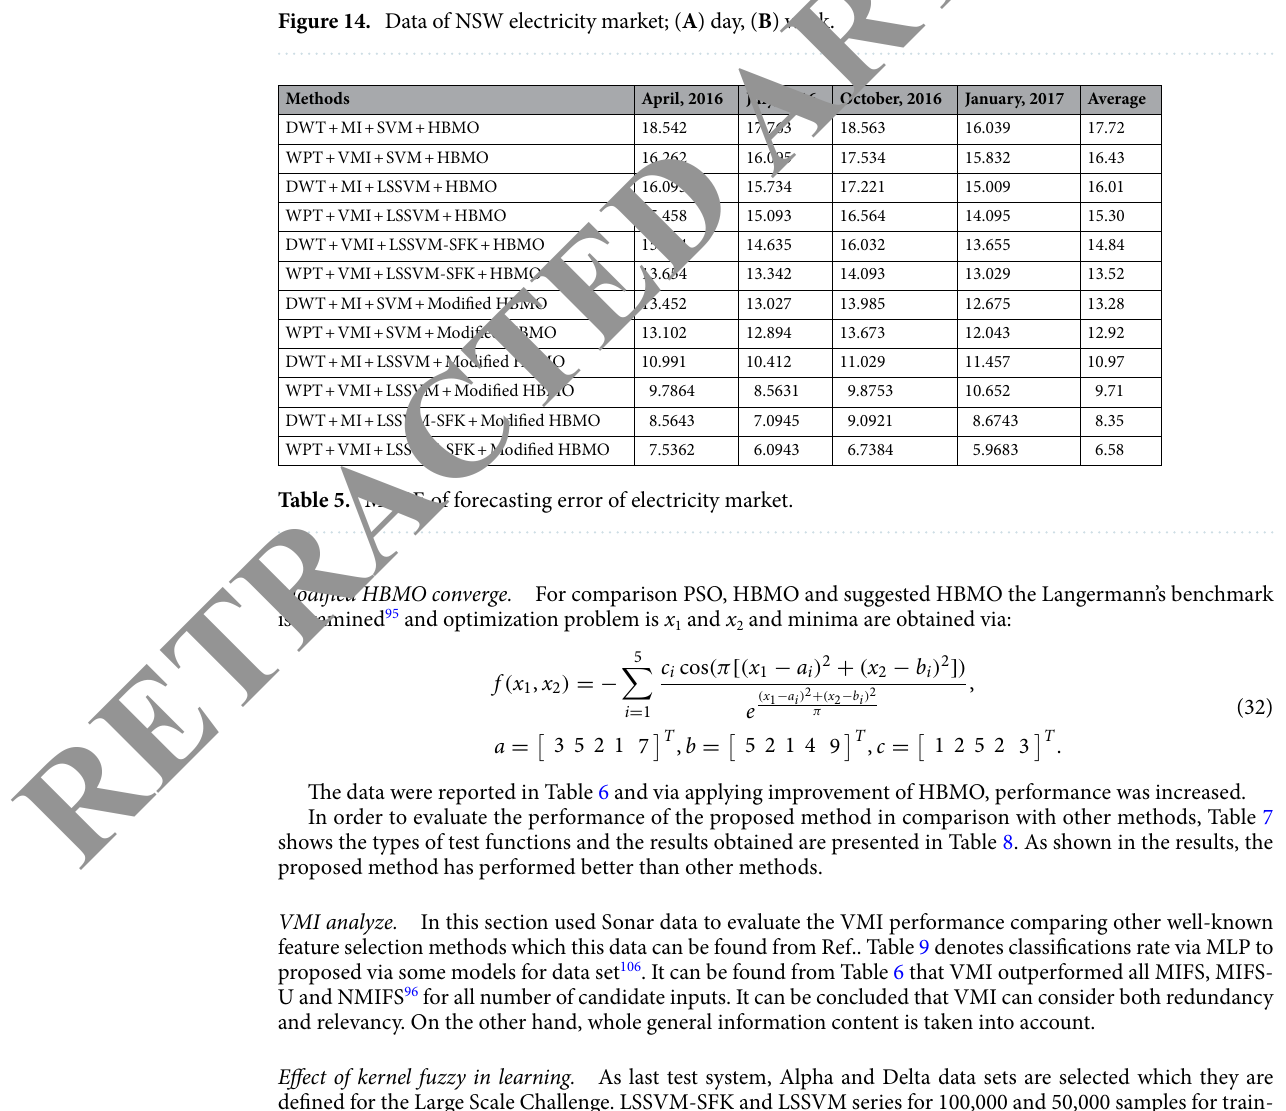
Figure 14. Data of NSW electricity market; ( A ) day, ( B ) week.